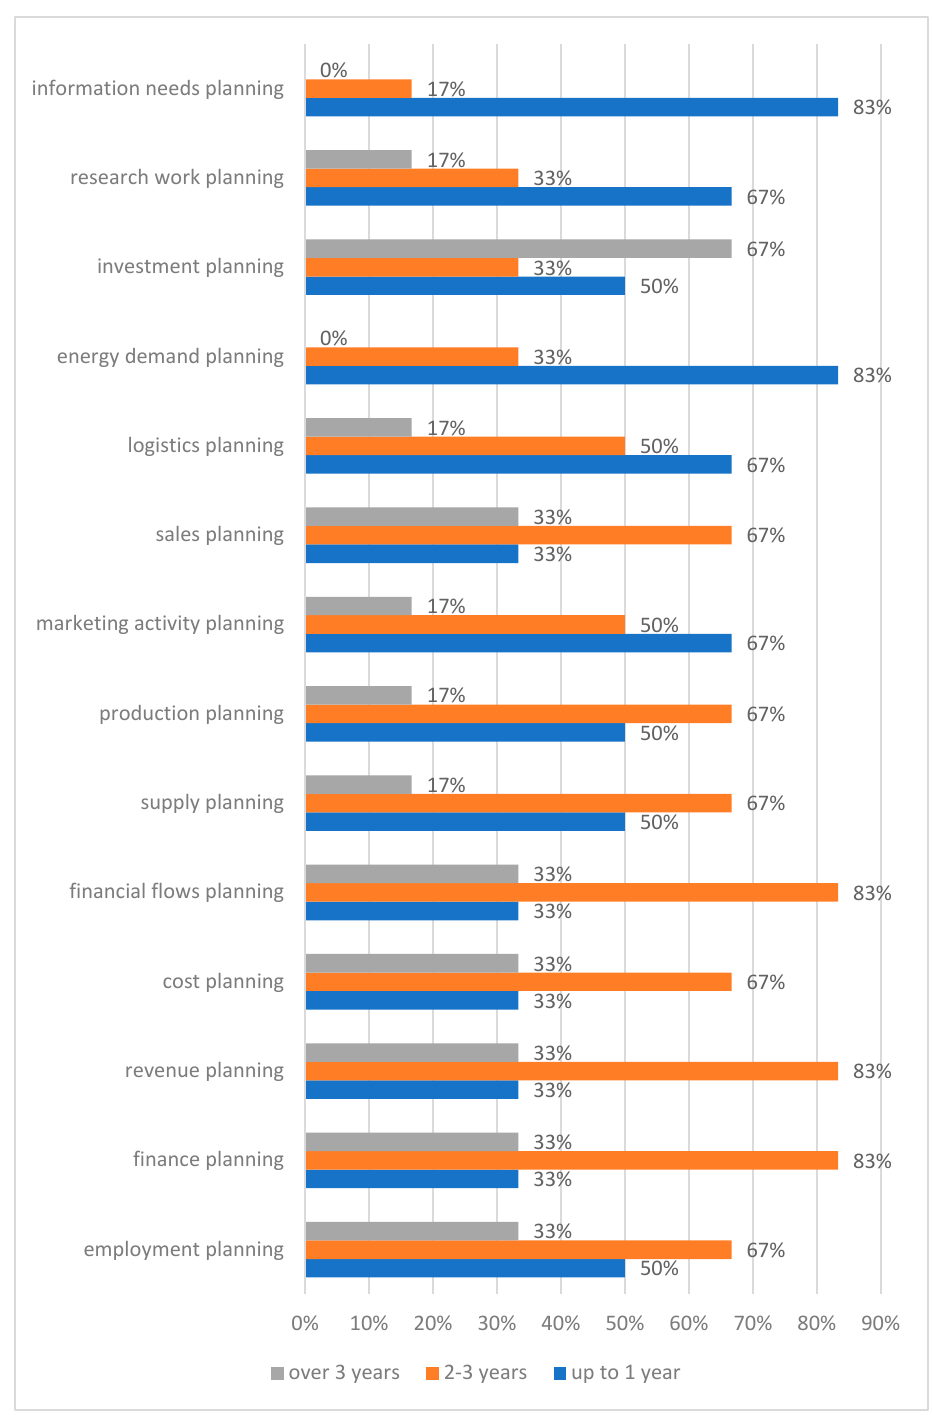
Figure 2. Planning decisions in the entities surveyed: up to 1 year, for 2–3 years, over 3 years. Source: own